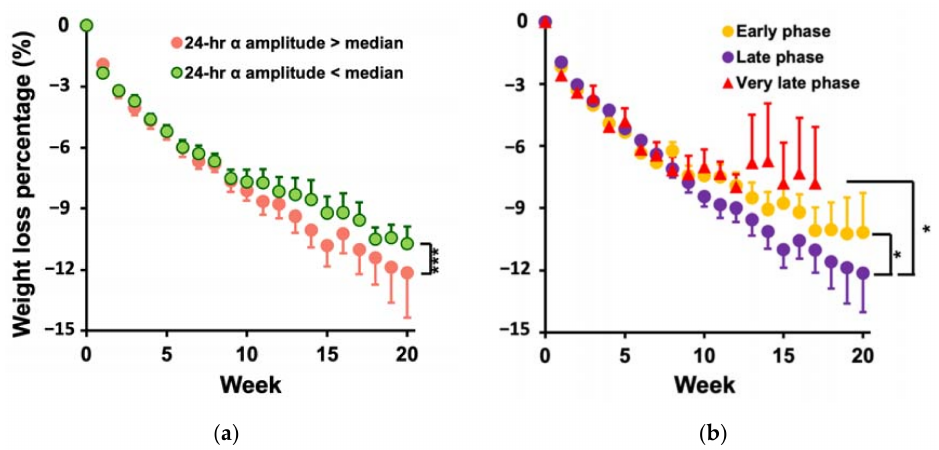
Figure 3. Association of weight loss evolution with the daily rhythm of FCD. Accumulative weight loss in each of the first 20 weeks over the dietary treatment in ( a ) individuals with small (<median) and large amplitudes (>median) and ( b ) individuals with early, late, and very late phases. The results and the p value were obtained from the Model 1b . Error bars indicate standard errors. * indicates p < 0.05, and *** indicates p < 0.0001 for the differences in WLS. Results were obtained after adjusting for daily energy intake and physical activity level.